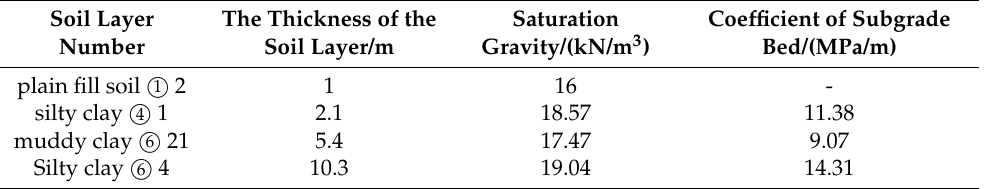
Table 2. Soil parameter. Soil Layer Number